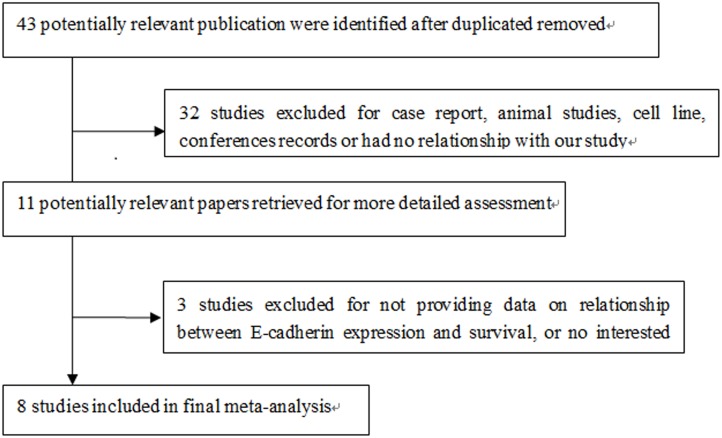
Process of study selection.